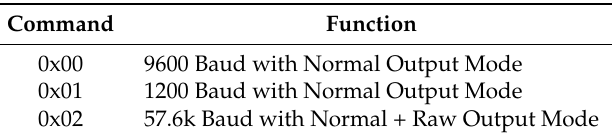
Table 4. Baud rate